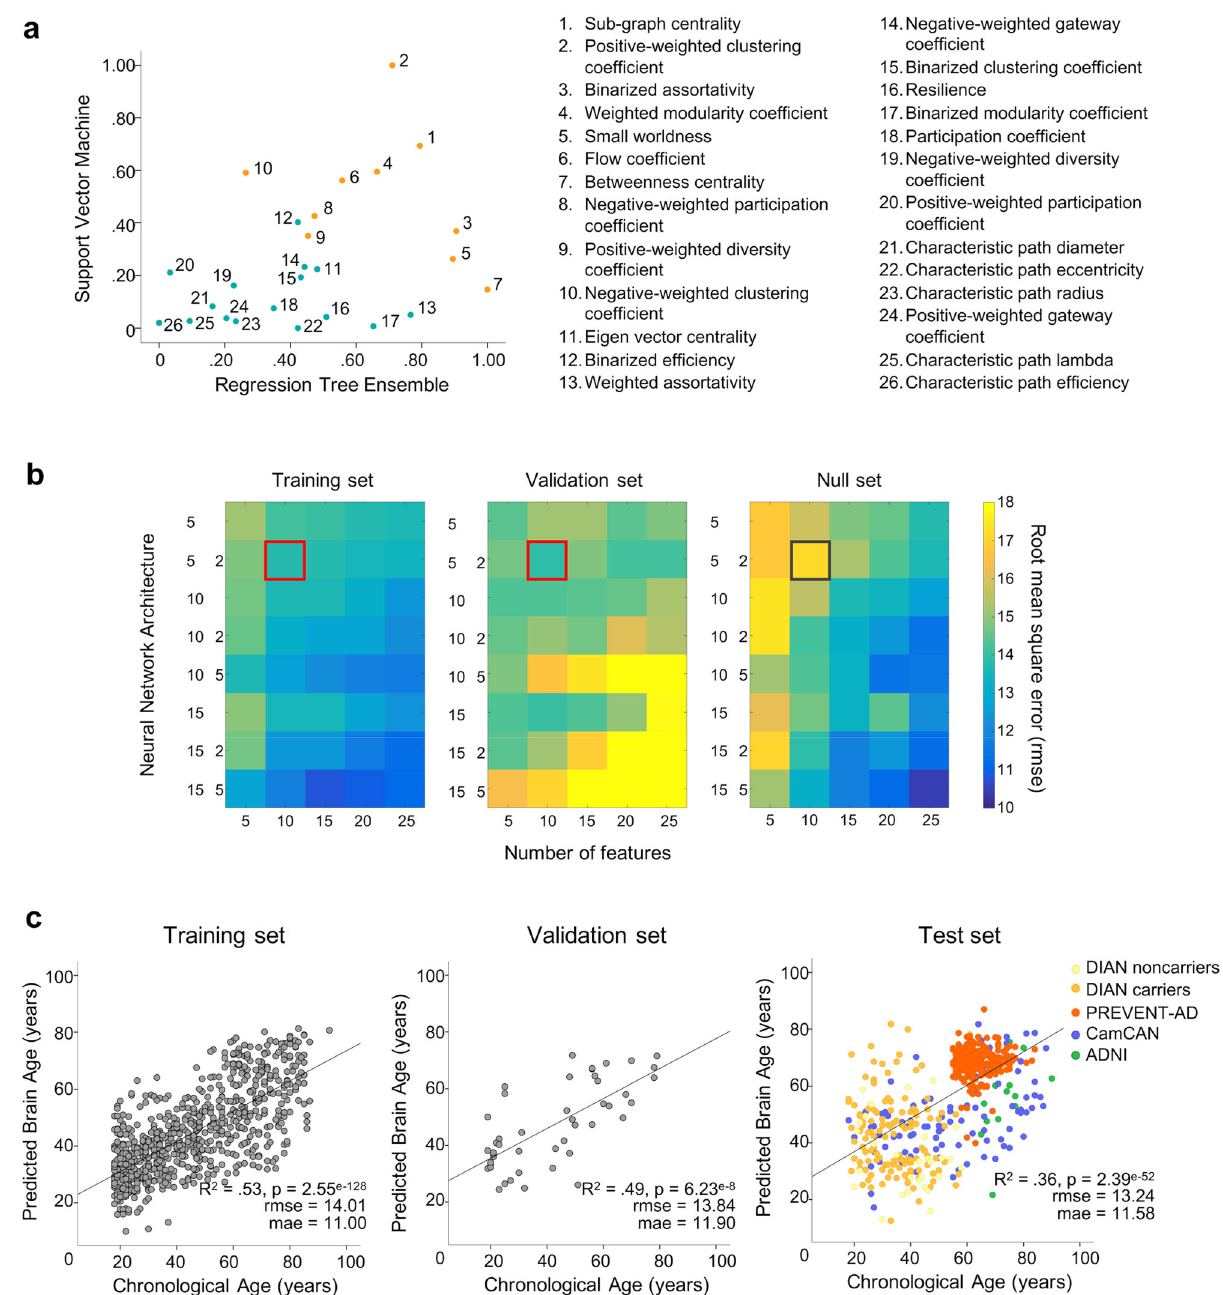
Fig. 2 Features ranking and neural networks performance. a Scatter plots of SVM model weights ( y -axis) and ensemble tree feature importance ( x -axis). Model weights are absolute value, and normalized such that 1 indicates highest importance. Numbers next to data points indicate their rank (i.e., 1 = highest average rank between both SVM and ensemble models; orange dots correspond to the top 10 features, blue dots represent lower-ranked features). b Root mean square error of different neural network models with inputs sorted according to rank for the training set (left), and the validation set (middle). Values were averaged over 3 iterations of the models. Neural networks trained with randomly-ranked inputs served as our null models (right). The x -axis indicates the number of inputs into the model (number of graph metrics) while the y -axis indicates the network architecture. For example, 5 means 1 hidden layer with 5 units, 5 2 means 2 hidden layers, the fi rst one with 5 units and the second with 2 units. Darker (blue) colors indicate higher accuracy, while lighter (yellow) colors indicate lower accuracy. The red square identifying the model that provides the better generalizability in the validation set (lowest rmse) contains 2 hidden layers of 5 and 2 units, and uses the 10 highest-ranked graph metrics as input. The same neural network trained on randomly-ranked inputs (null model, gray square) provides lower accuracy. c Brain age model performance across datasets. Correlations between chronological age ( x -axis) and age predicted by the neural network ( y -axis) are represented for the training ( n = 773), validation ( n = 46) and test ( n = 521) sets. Statistical values ( c ) were obtained from Pearson ’ s correlations (two-sided test, with no adjustment). Source data are provided as a Source data fi le. SVM: support vector machine, rmse: root mean square error, mae: mean absolute error.